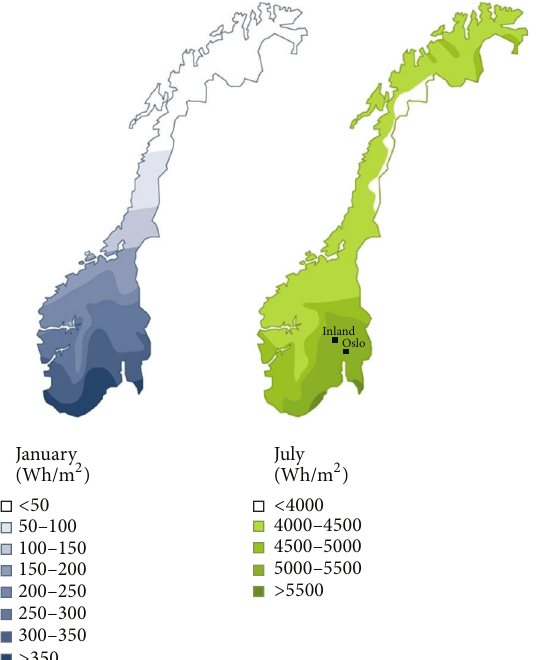
Figure 1: Monthly average daily global solar radiation map of Norway for the months of January and July [Wh/m 2 /day] [32].